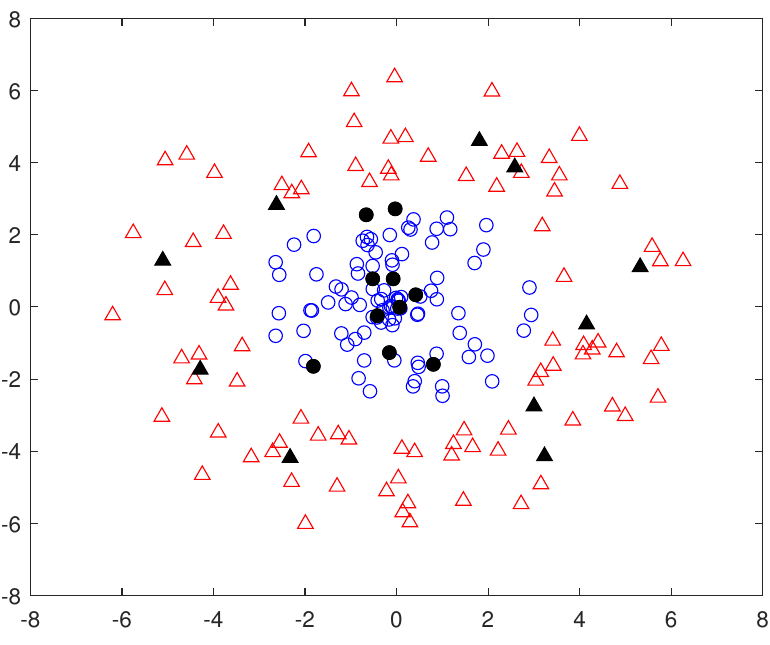
Figure 1. The distribution of the simulated